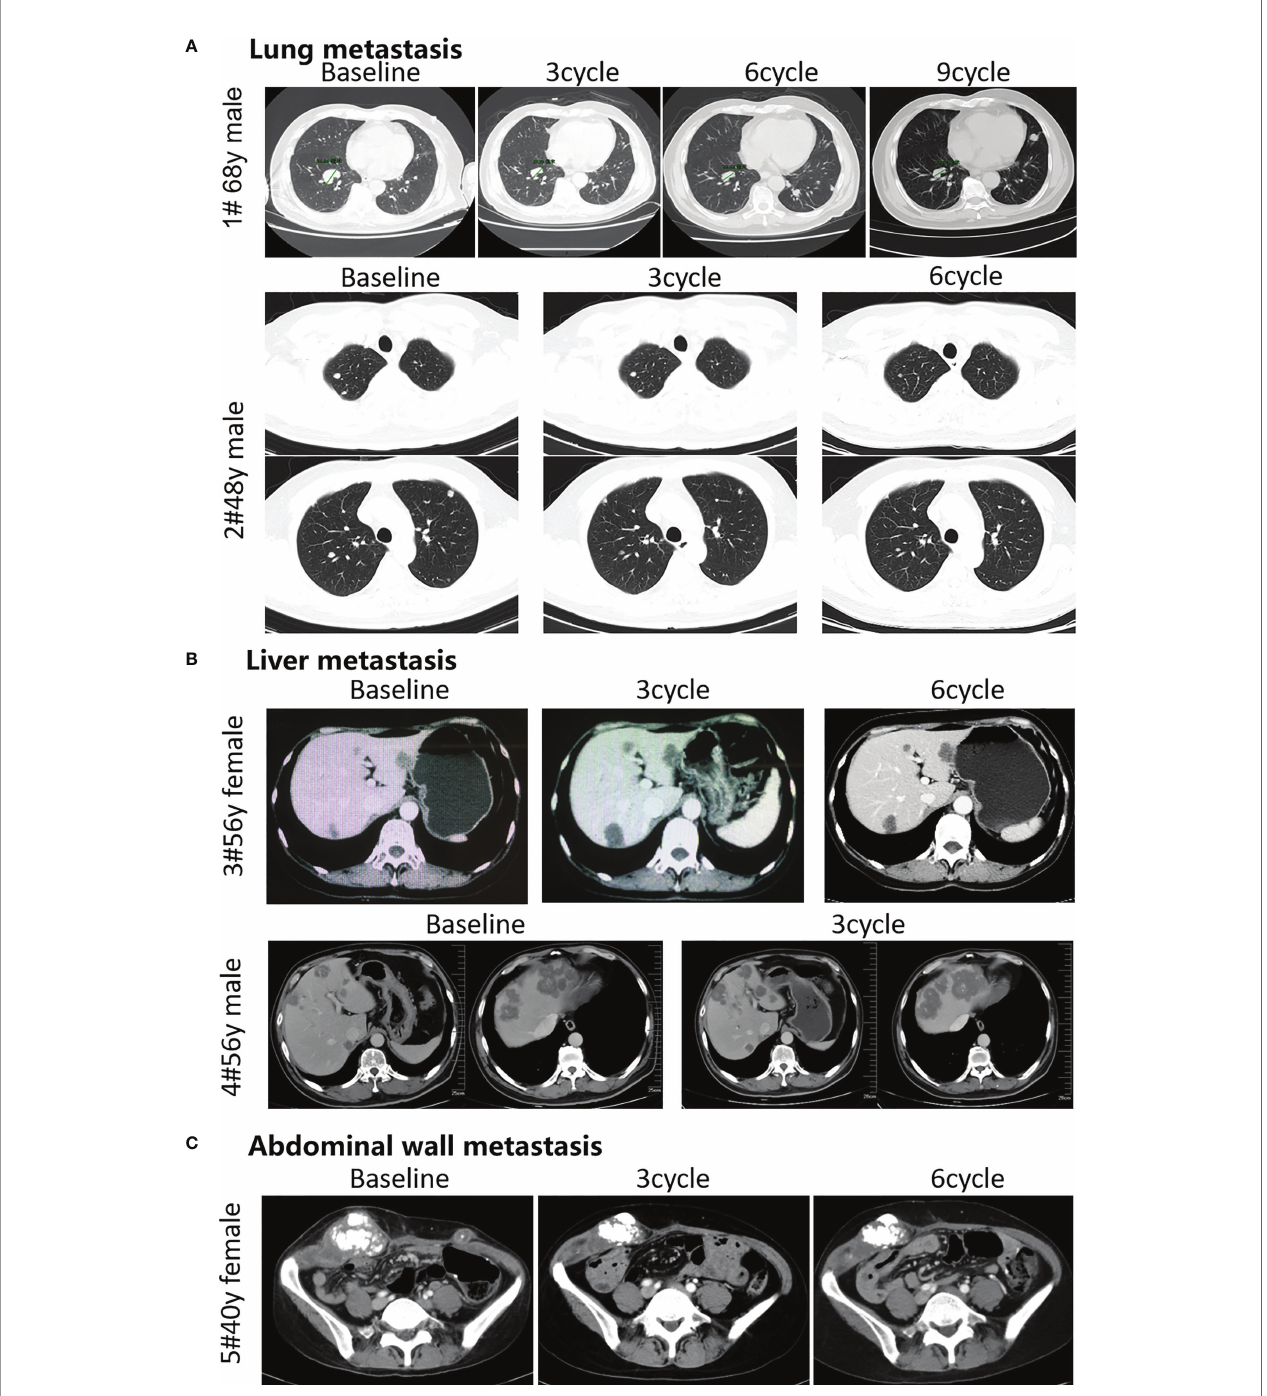
FIGURE 6 | Ef fi cacy of the combination therapy of fruquintinib and anti-PD-1 in patients in MSS mCRC. Radiologic evidence of the 5 patients who achieved PR or SD after the combination treatment. CT scans were performed at the baseline and subsequent treatment cycles. (A) Two CRC patients with lung metastasis: (case 1 # and case 2) were treated with anti-PD-1 and Fruquintinib, and the lesions were signi fi cantly reduced (PR). (B) Two CRC patients with liver metastasis: (case 3and case 4) were treated with anti-PD-1 and fruquintinib, the liver metastases showed stable morphological changes, the density became uniform and reduced, the edge became clear, and the peripheral edge enhancement disappeared. (C) One CRC patient with abdominal wall metastasis (case 5) were treated with anti-PD-1 and fruquintinib, and the lesions were signi fi cantly reduced (PR). Individual clinical outcomes and the 5 patients enrolled by therapeutic responses (assessed via RECIST v1.1) in Table 1 . No, patient number; y, years old; PR, partial response; SD, stable disease; PD, progressive